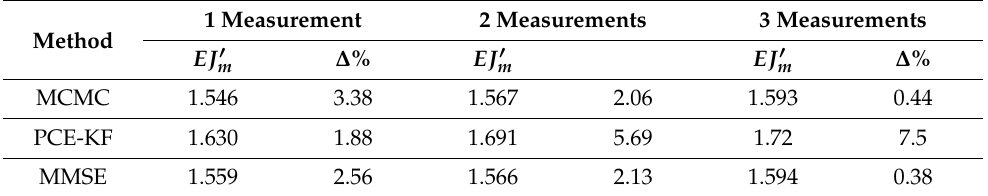
Table 7. Performance of the different updating procedures after mapping the response: comparison of posterior mode EJ (cid:48) m and EJ true = m + 3 s = 1.6.